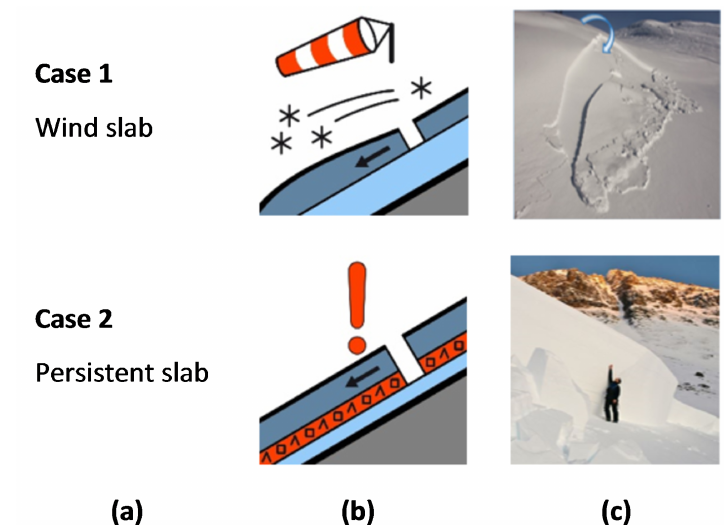
Figure 6. Test of what communicates the avalanche problem best in the avalanche warning: (a) text, (b) symbols or (c)